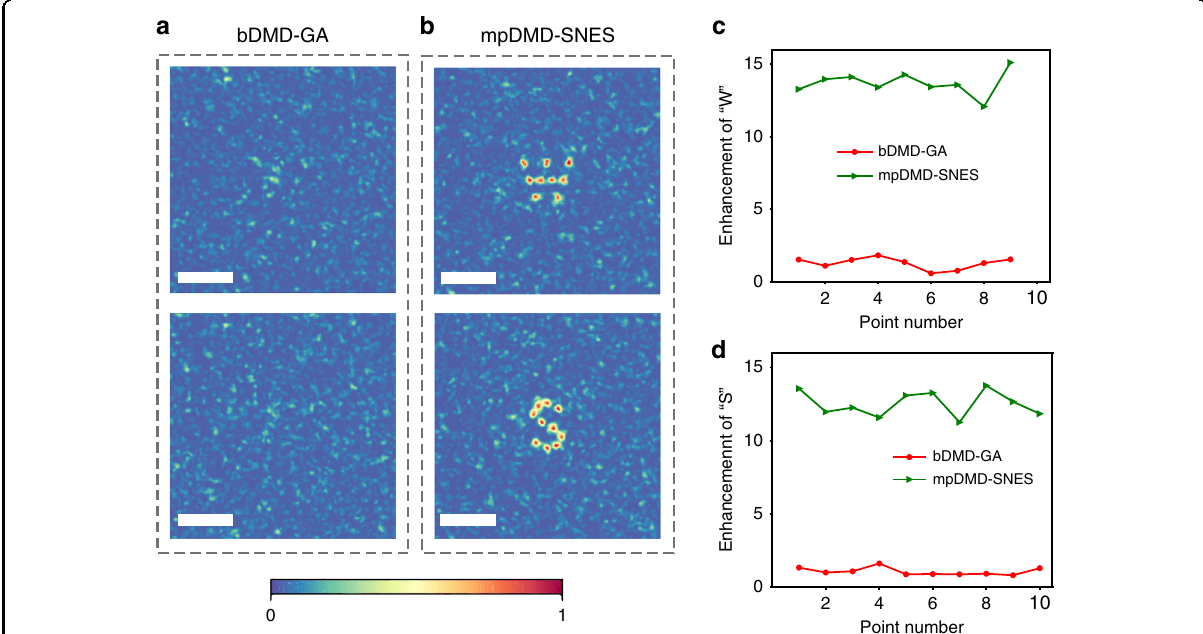
Fig. 6 Multi-focus control experiments. a , b Images of the foci optimized by the bDMD-GA ( a ) and the mpDMD-SNES WS methods ( b ). Scale bar, 500 µm. c , d Enhancement for each focus in the W- ( c ) and S-shape ( d )